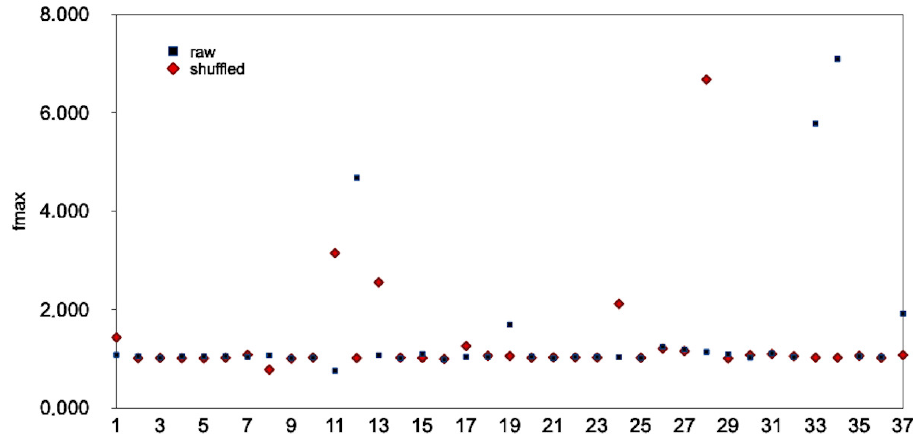
Figure 7. Scatter plot of f max values versus the i/i value of Table 2. Blue dots indicate the raw two-month series and the red dots the shuffled series.